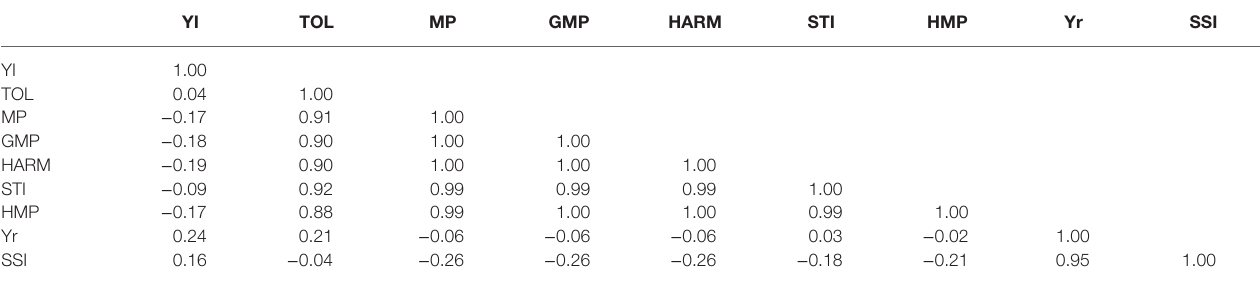
TABLE 3 | The correlation coefficient between drought stress conditions and drought tolerance indices between 2012–13 and 2019–20. YI TOL MP